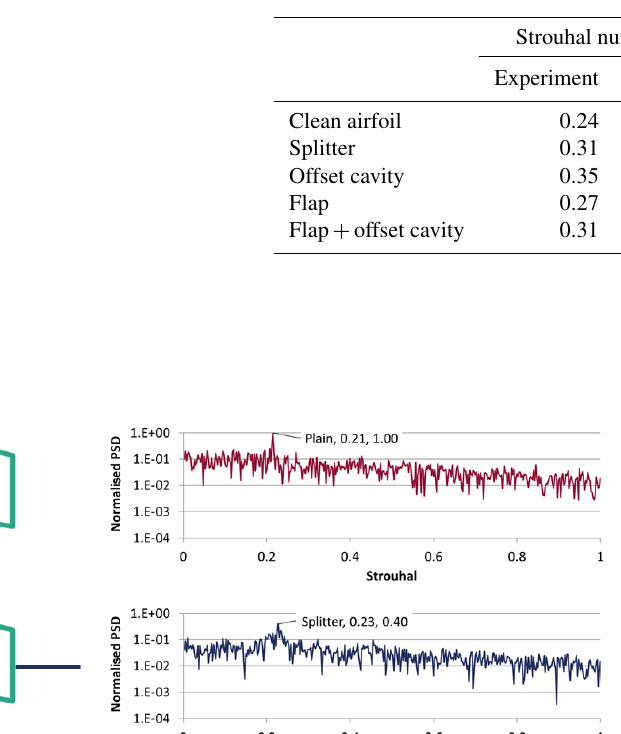
Table 1. Strouhal number ( St = f h TE /V ∞ ) and normalised peak amplitude of the frequency spectrum for the plain airfoil and the airfoil with different TE devices: comparison between experiments and IDDES simulations.